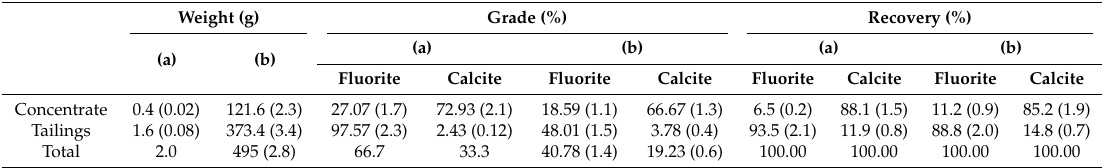
Table 1. The results of mixed binary minerals (a) and run-of-mine fluorite ore (b) flotation tests using the reagent schedule of CA + NaF + SOA at pH